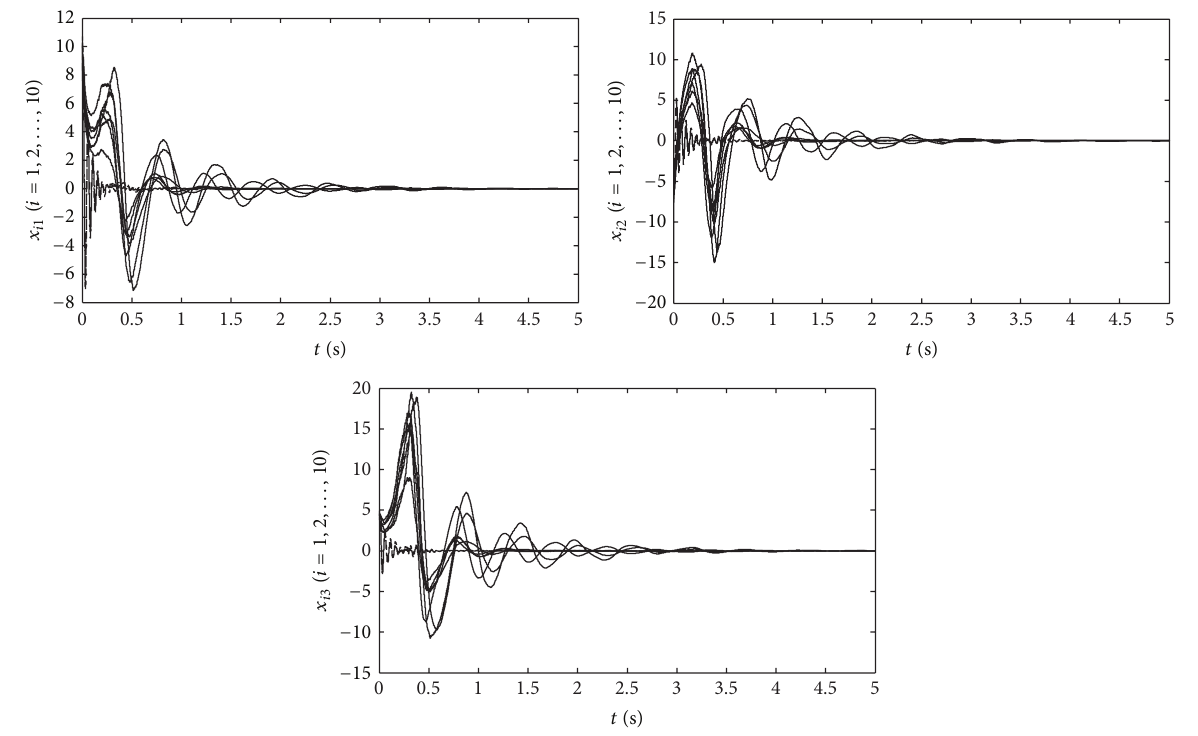
Figure 4: The states of complex networks with an 𝑚 -reducible coupling matrix 𝐶